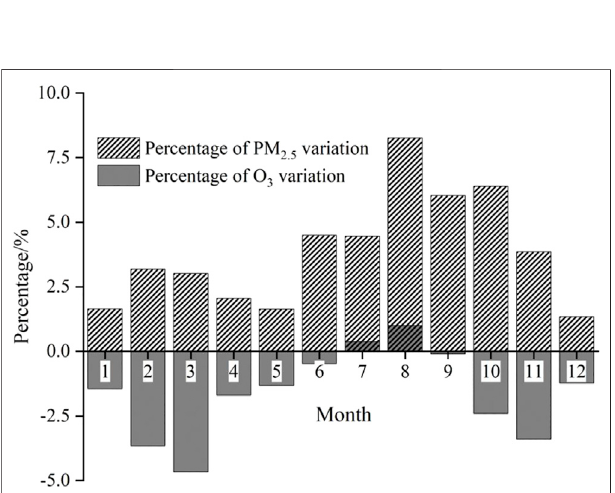
FIGURE 4 | Simulated PBLH reduction percentage caused by the DRE in 2021.